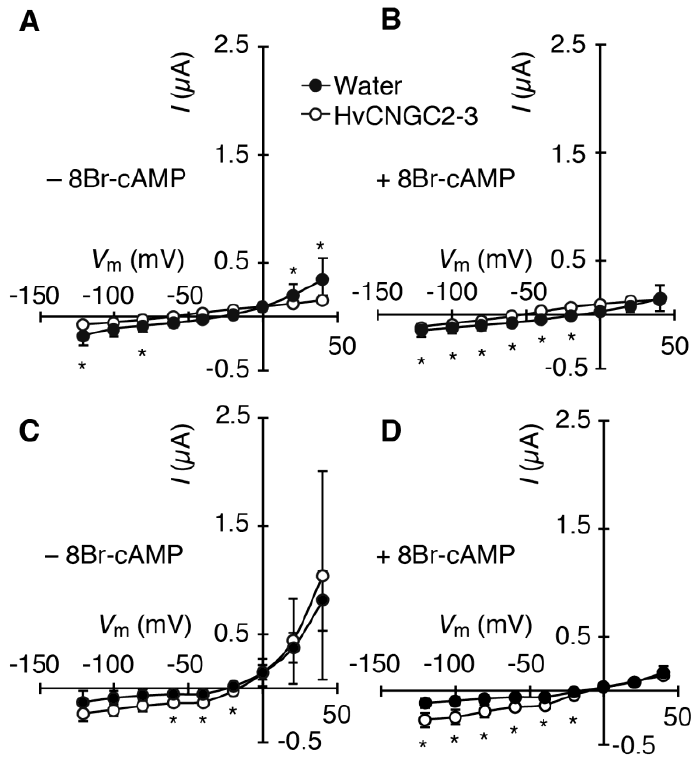
Figure 3. Current/voltage relationship of HvCNGC2-3-expressing oocytes in Na + and K + media. Currents were recorded by the two-electrode voltage-clamp technique. HvCNGC2-3 cRNA-injected oocytes (open circles), water-injected control oocytes (closed circles). ( A , B ) bath solution containing a Na + medium (96 mM NaCl); ( C , D ) bath solution containing a K + medium (96 mM KCl). Oocytes were treated with ( B , D ) or without ( A , C ) 8Br-cAMP (10 µM) 30 min before measurement. Current values are means ( n = 14 [panel A], 7 [panel B], 13 [panel C] and 7 [panel D] for water-injected control, and n = 6 [A], 6 [B], 13 [C] and 7 [D] for HvCNGC2-3) ± SD. I , membrane current. V m, membrane potential. Asterisks indicate significant difference of the means between HvCNGC2-3 cRNA-injected oocytes and water-injected control oocytes (Student’s t -test, p < 0.05).